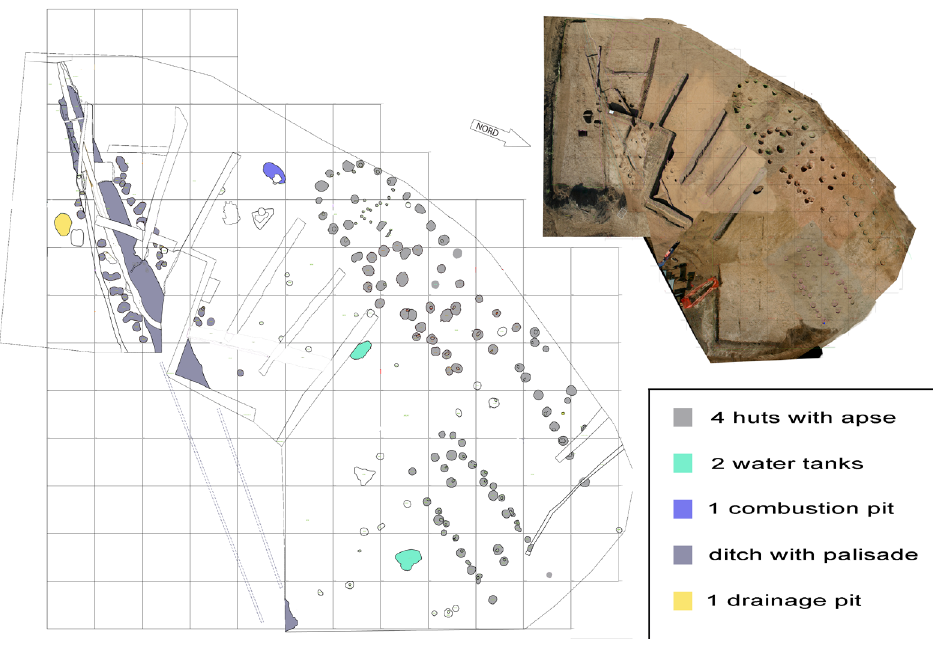
Figure 2. S–F area on the Piani della Corona